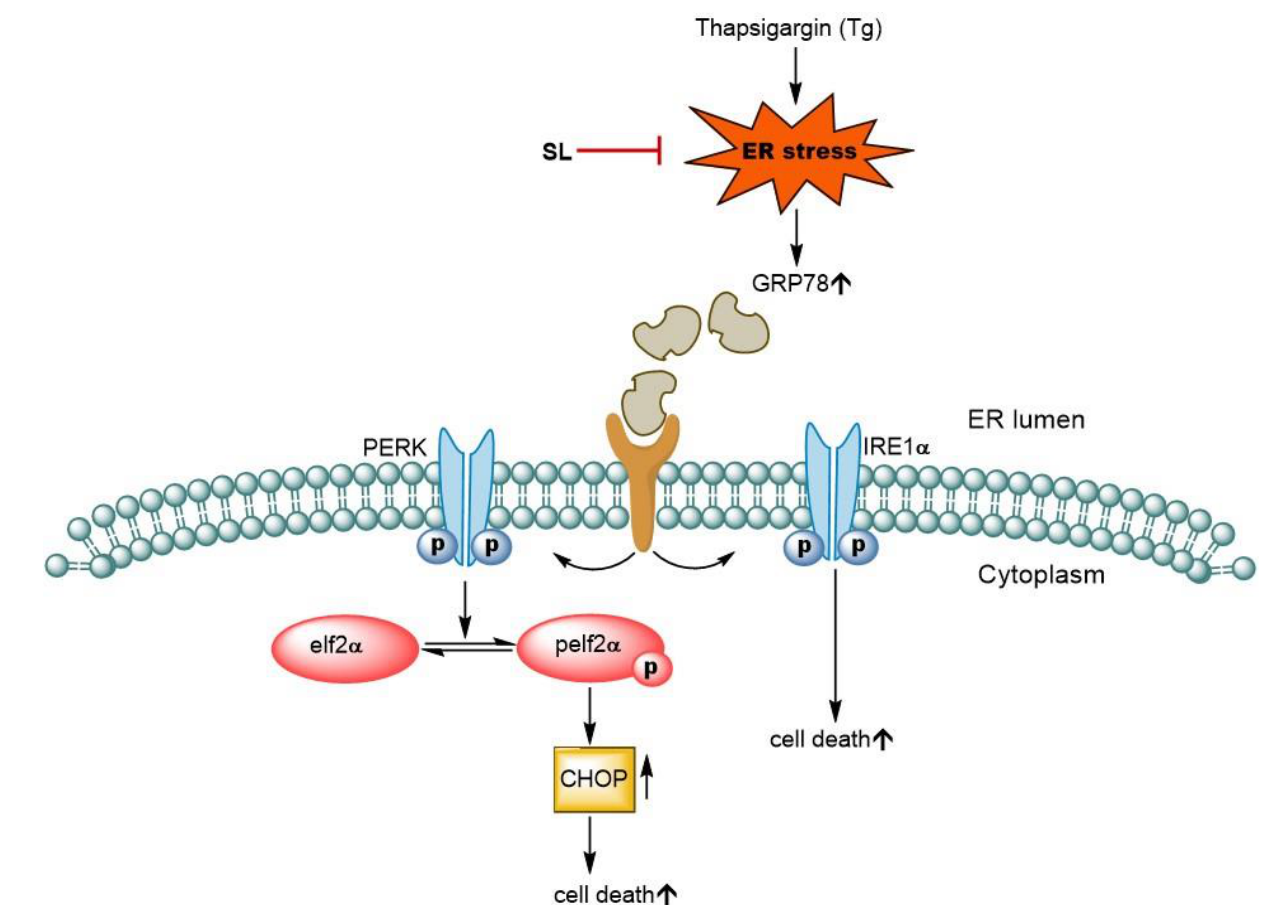
Figure 7. Diagram for the underlying mechanism of SL in protecting Tg-induced ER stress and apoptosis in endothelial cells. Thapsigargin (Tg) is an inhibitor of Sarco endoplasmic reticulum Ca 2+ ATPase (SERCA). Tg leads to calcium depletion in ER, causing ER stress. ER stress mediates cell apoptosis through the GRP78-dependent PERK- Elf2α - CHOP pathway and pIRE1α pathway. SL pretreatment is shown to mainly reduce the level of CHOP via the PERK pathway. Overall, SL treatment could decrease the inducti on of IRE1α and PERK signals through downregulation of GRP78 , and could suppress the CHOP protein in endothelial cells treated with the ER stress inducer, Tg.